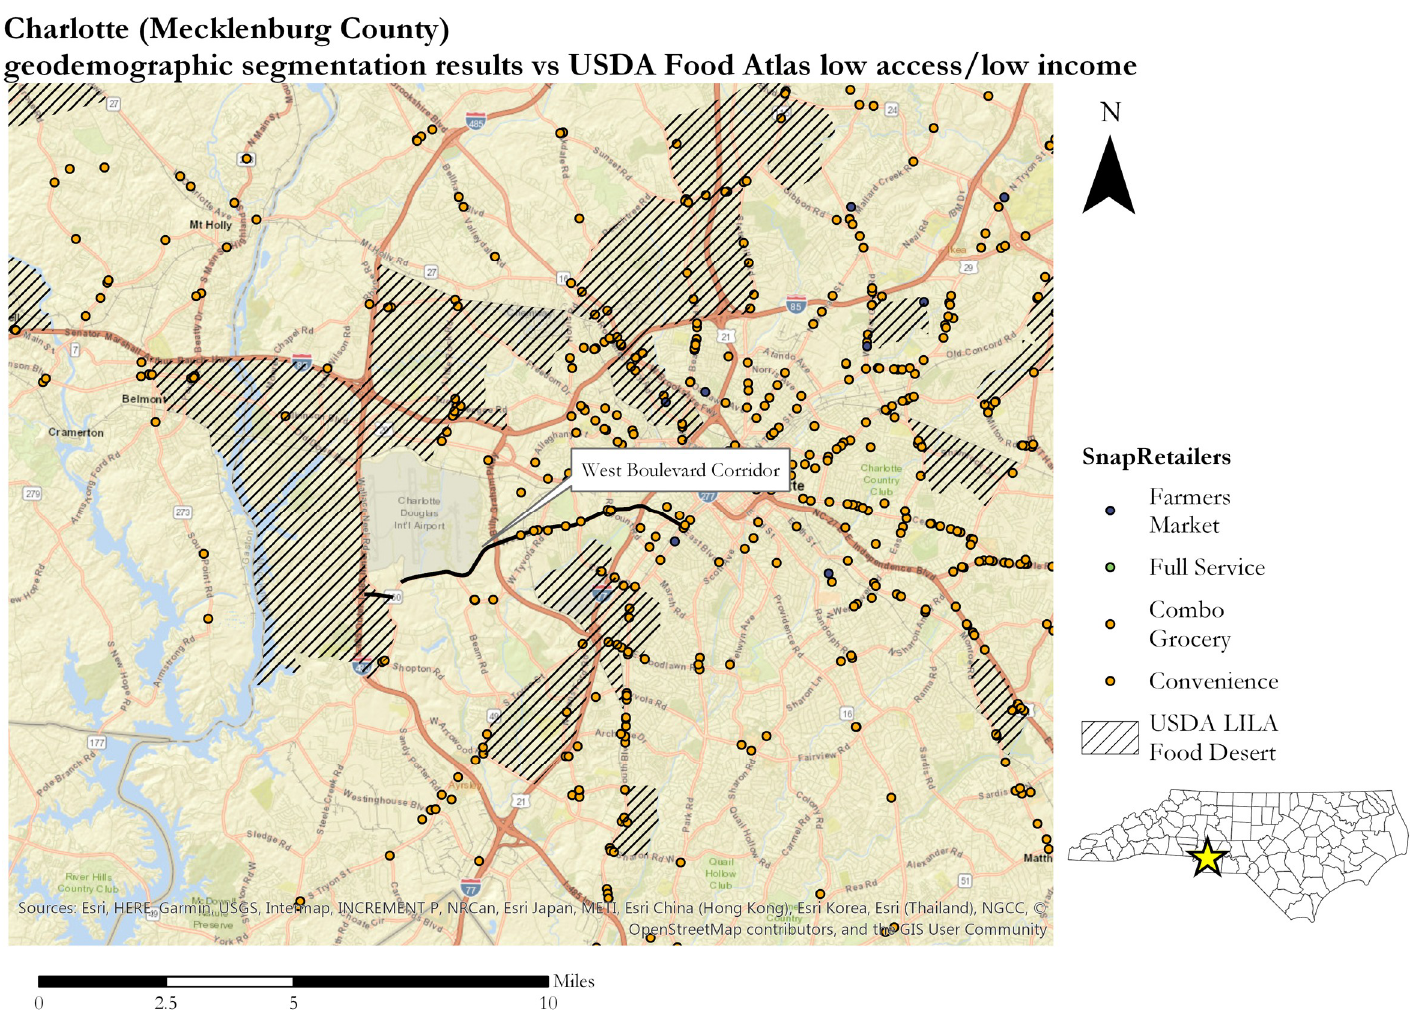
Figure 1. USDA’s Low Income/Low Access tracts (LILAs) in the Charlotte Mecklenburg area.